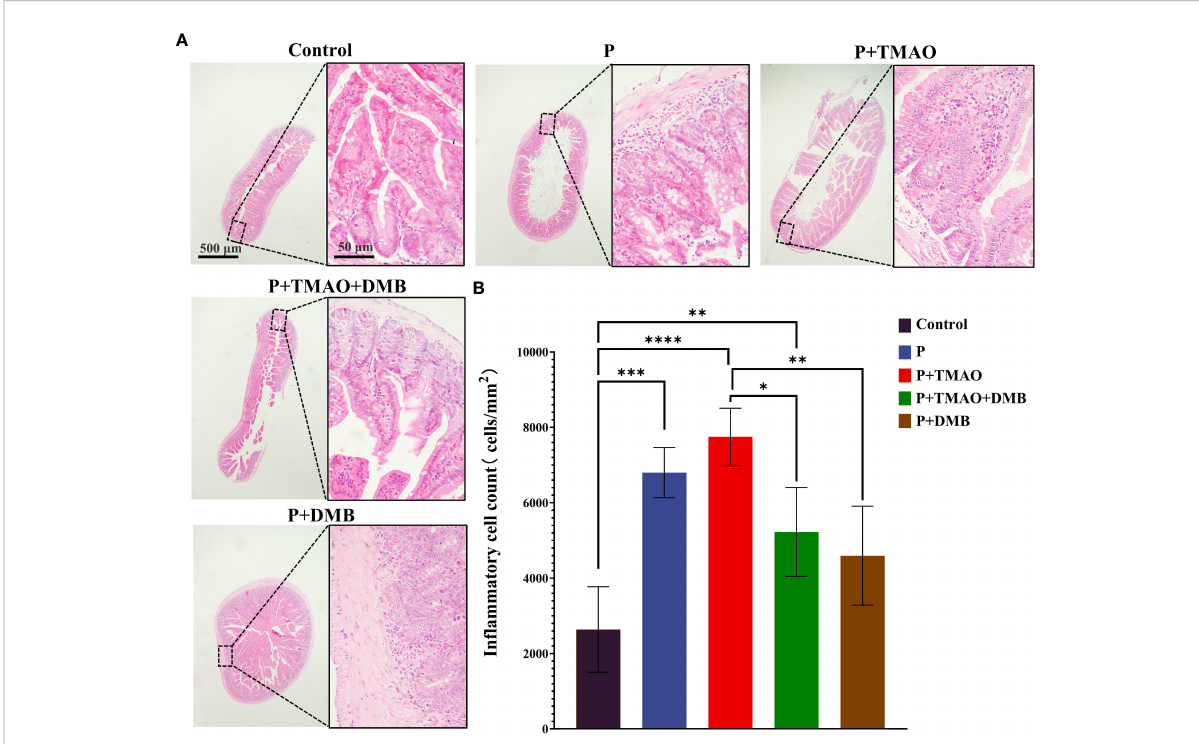
FIGURE 1 TMAO promotes intestinal in fl ammation in mice with periodontitis. (A) Representative pictures of intestine tissue by HE dyeing. (B) Quanti fi cation of monocytes, macrophages, lymphocytes, and neutrophils in intestinal HE samples.. The symbols *, * *, * * *, and * * * * have the meanings P ≤ 0.05, P ≤ 0.01, P ≤ 0.001, and P ≤ 0.0001,